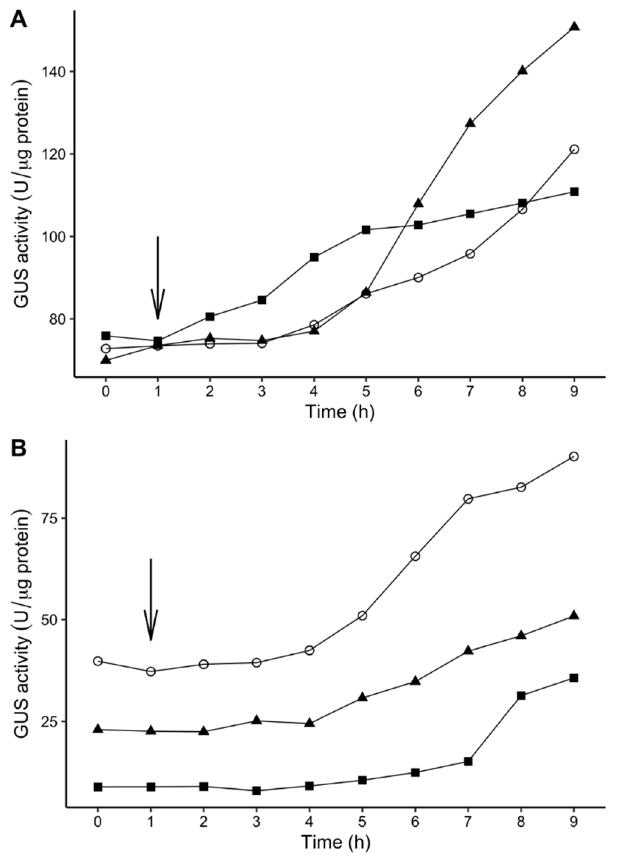
Figure 5. Effect of temperature shift on GUS activity in the transposon mutants of P. atrosepticum SCRI1043. Bacteria were grown to OD 600 of 1.0 (t = 0 h) at the non-inductive temperature, incubated for an additional hour, and then shifted (arrow) to the gusA -expression-inductive temperature. Values are the means of three replicates per strain. Effect of temperature shift from 28 °C to 18 °C on GUS activity in P. atrosepticum SCRI1043 mutants with higher levels of GUS activity at 18 °C: PbaTn5-38 (open circle), PbaTn5-43 (closed triangle), PbaTn5-B76 (closed square) ( A ). Effect of temperature shift from 18 °C to 28 °C on GUS activity in P. atrosepticum SCRI1043 mutants with higher levels of GUS activity at 28 °C: PbaTn5-A33 (closed square), PbaTn5-B25 (open circle), PbaTn5-B42 (closed triangle) ( B ).